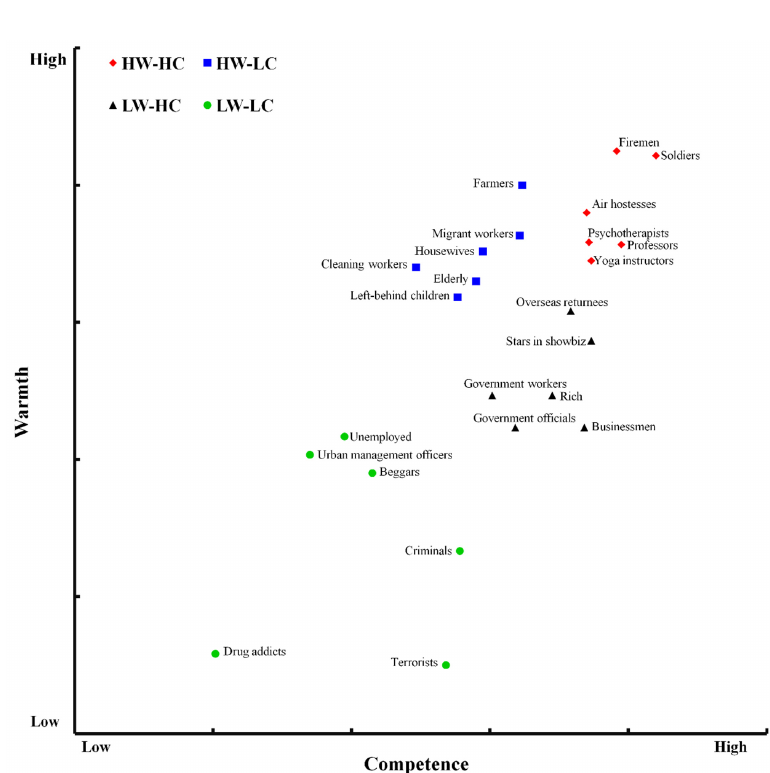
Figure 3. SCM map in mainland China based on 24 typical social